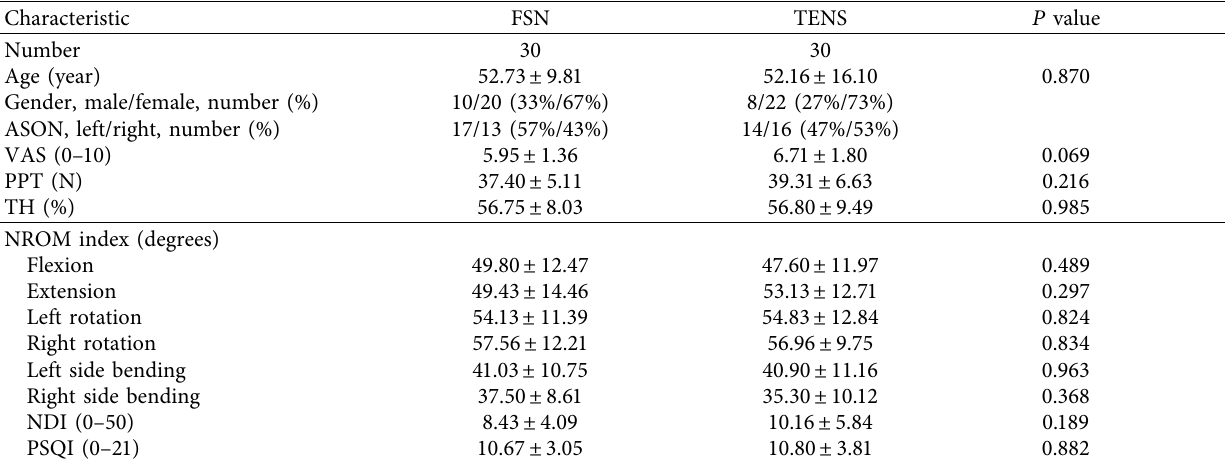
Table 1: Baseline characteristics of participants in two groups.